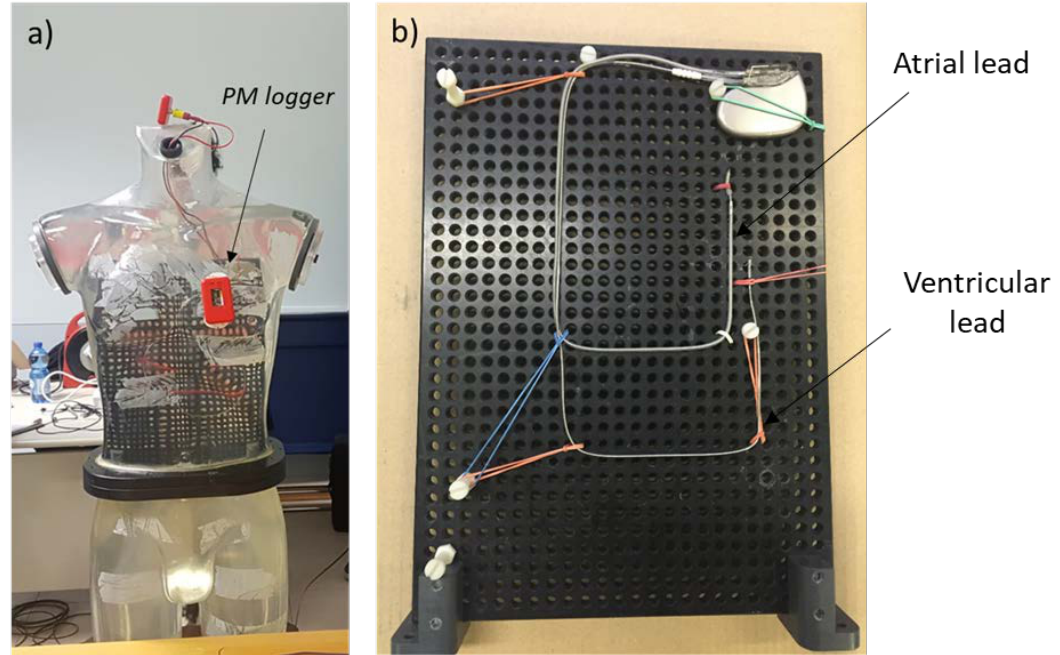
Figure 1. ( a ) The human torso-shaped phantom used for the in vitro testing / measurements. The custom-made logger used to monitor the pacemaker (PM) activity is shown by the arrow; ( b ) PM implant